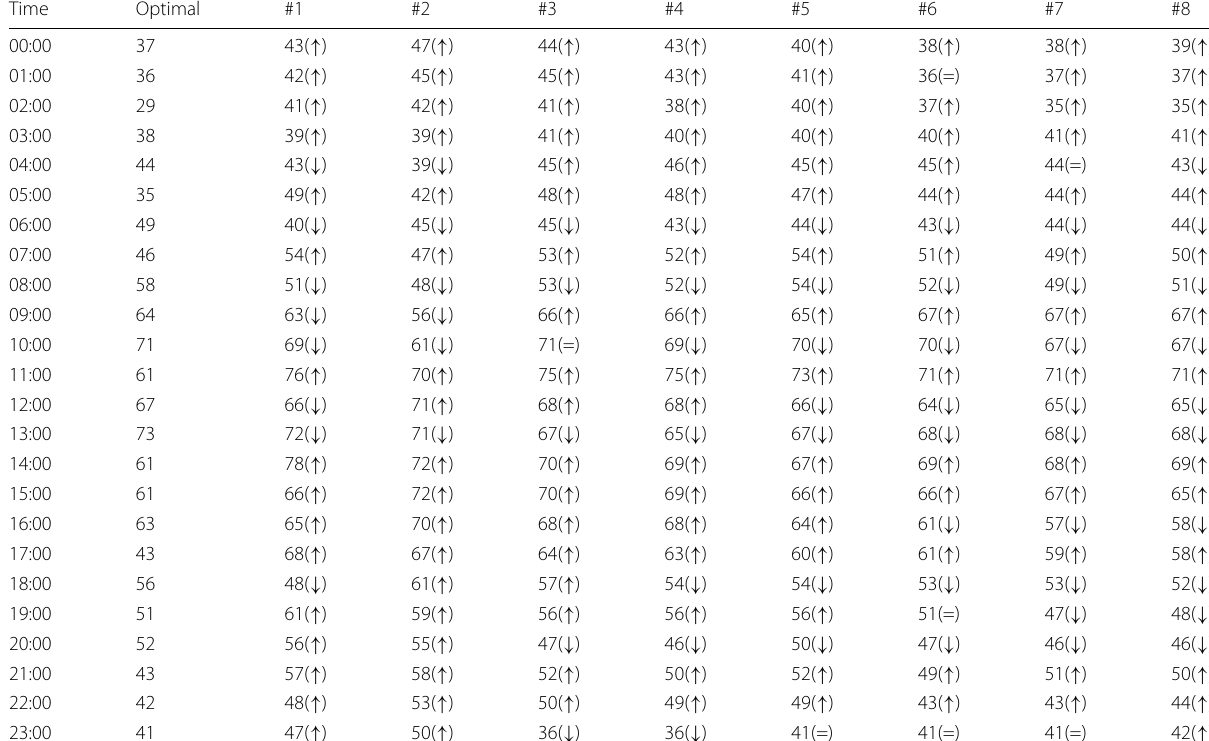
Table 6 Allocation 2: Optimal resource allocation (based on real load) vs. estimated resource allocation (based on predicted loads plus half the expected error, forecasting models #1 to #8)